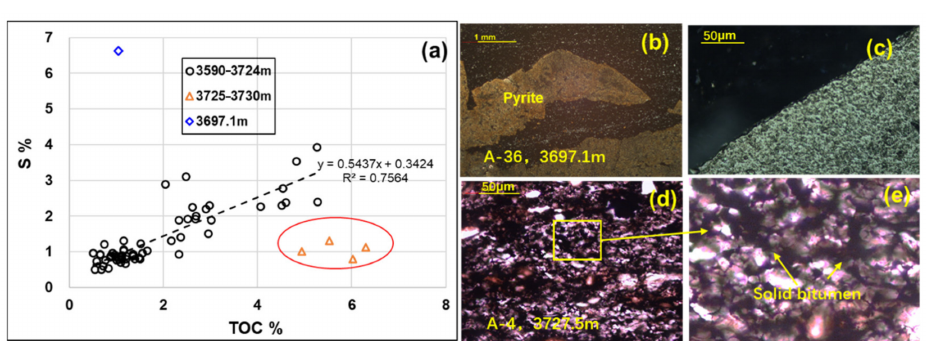
Figure 10. ( a ) The plots of TOC and S contents. ( b , c ) The micro-photos of A-36 (3697.1 m), showing pyrite agglomerate developed in this sample, reflect light. ( d , e ) The micro-photos of A-4 (3727.5), showing much solid bitumen filled (red oval in Figure 10a, and arrows) in the micropore surrounding the mineral